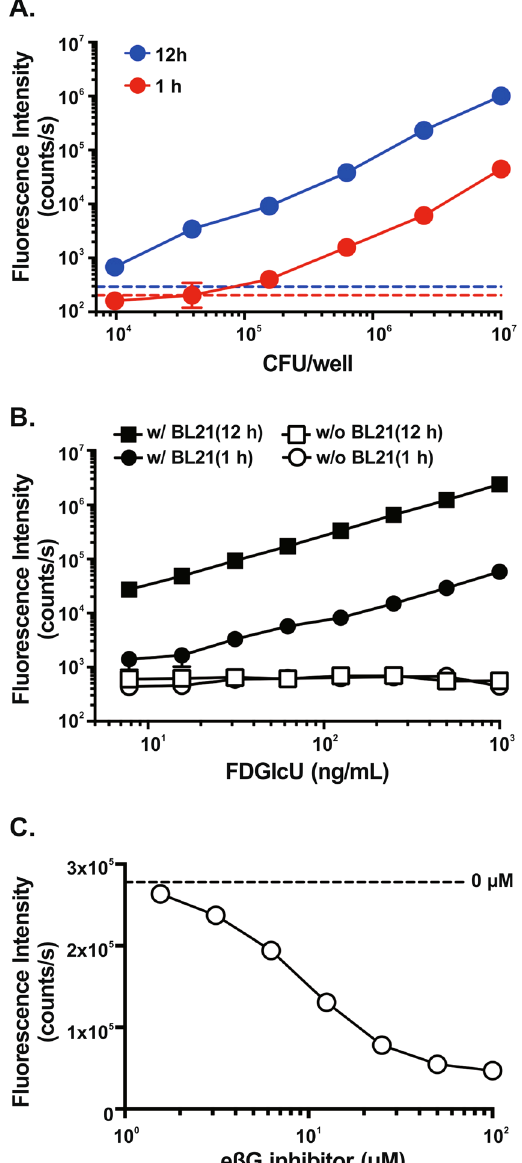
Figure 1. Hydrolysis of FDGlcU in cell-based assays and inhibition by the e β G inhibitor. ( A ) Fluorescence intensity of 0.5 μ g/mL FDGlcU hydrolyzed by various amounts (CFU/well) of BL21 cells after 1-hour (red dots) or 12-hour (blue dots) incubations. Dashed lines indicate the absence of BL21 cells in the 1-hour (red line) or the 12-hour (blue line) incubation. ( B ) Fluorescence intensity of various concentrations of FDGlcU hydrolyzed by 10 7 CFU/well of BL21 cells after 1-hour ( ● ) and 12-hour ( ■ ) incubations. (☐) and ( ○ ) indicate the absence of BL21 cells. ( C ) Fluorescence intensity of 1 μ g/mL of FDGlcU hydrolyzed by 6.25 × 10 5 CFU/well of BL21 cells in the presence of the e β G inhibitor at various concentrations ( μ M) after the 12-hour incubation. The dashed line indicates the absence of the e β G inhibitor. Error bars indicate